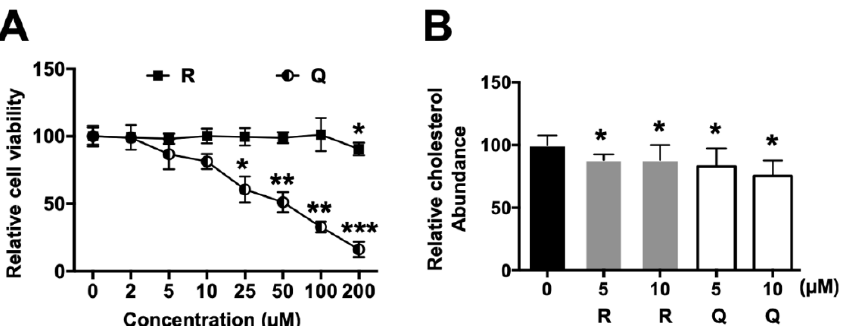
Figure 2. ( A ) Cytotoxicity of rutin (R) and quercetin (Q). HepG2 cells were incubated with R or Q for 24 h; thereafter, cell viability was measured by MTT assay. ( B ) Changes in total cholesterol content in HepG2 cells with incubation of R or Q. Each value represents the mean ± standard deviation from 3 representative experiments. *** p < 0.005; ** p < 0.01; or * p < 0.05 compared with vehicle group.